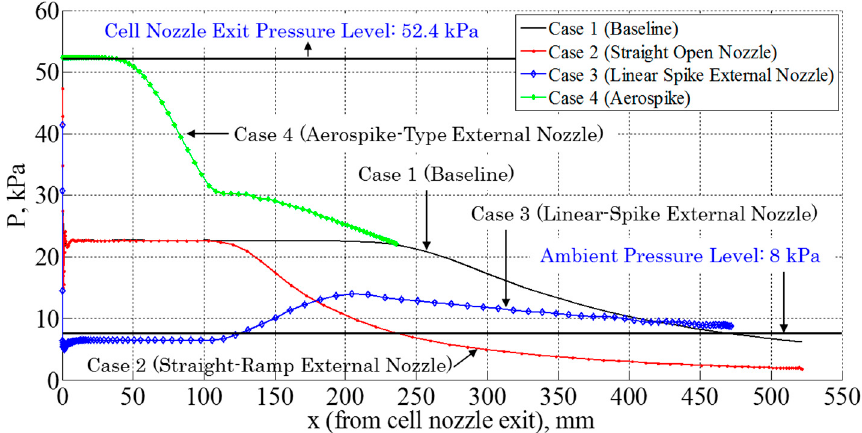
Figure 12. Comparison of the wall pressure distribution on the external nozzle among Cases 1 to 4. The nozzle surface pressure was obtained by the CFD calculation. The location of x = 0 indicates the cell nozzle exit.